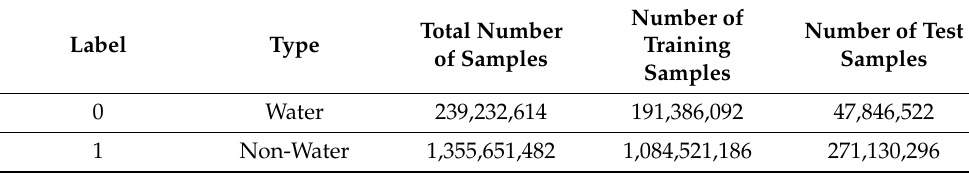
Table 2. Ground truth samples in one scene SAR image in the study area.